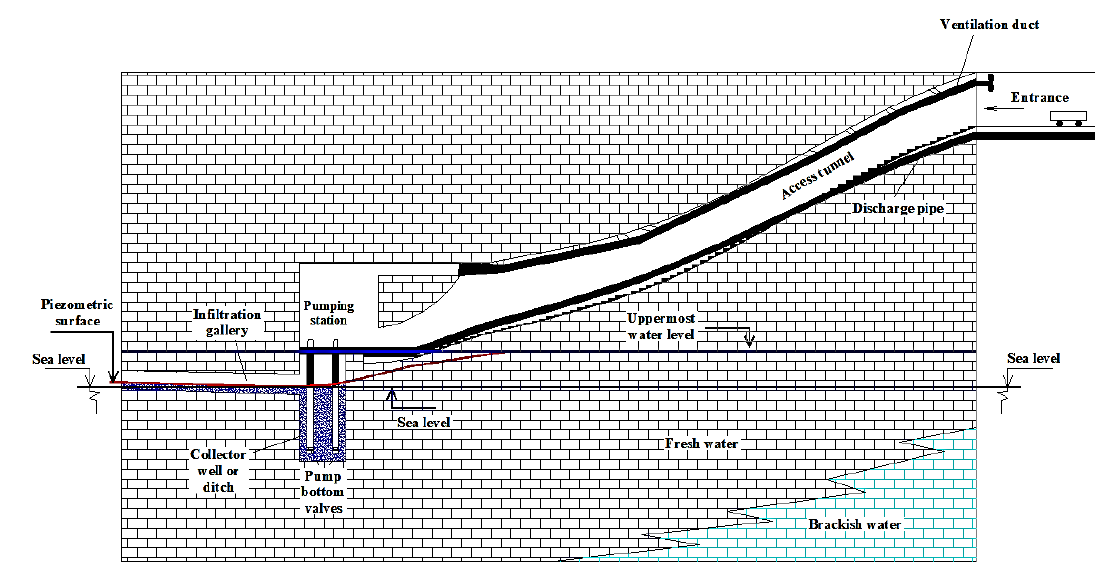
Figure 8. Almyros spring and the dam with a height of 10 m.